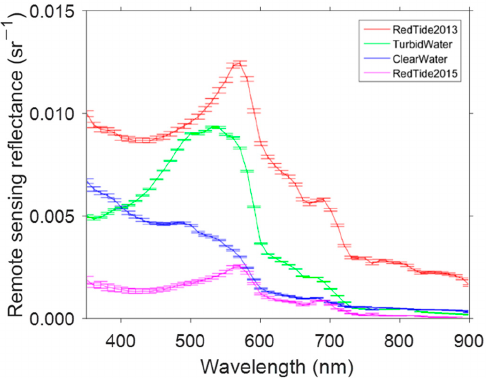
Figure 4. In situ spectral remote sensing reflectances ( R rs ) as a function of wavelength at the southern coast of the Korean Peninsula, where red and magenta-colored R rs represent red tide water in 2013 and 2015, respectively, and green and blue lines represent the R rs of turbid water and clear water, respectively. The upper and lower limits of the bars stand for the range of mean errors of R rs with 1 standard errors at each wavelength.